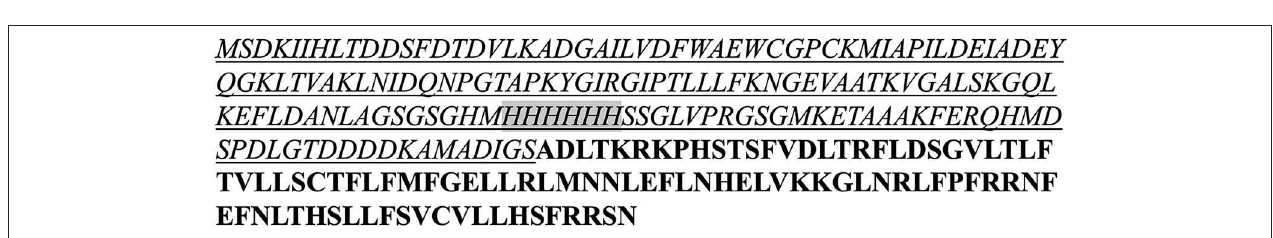
FIGURE 7 | Amino acid sequences of the recombinant fusion protein TP04_0076F. The fusion protein contains 260 aa (single letter peptide) with the vector portion underlined and the 6x His tag used for affinity purification shadowed. The TP04_0076 portion is bolded, and the methionine (M) start codon was not included in the fusion